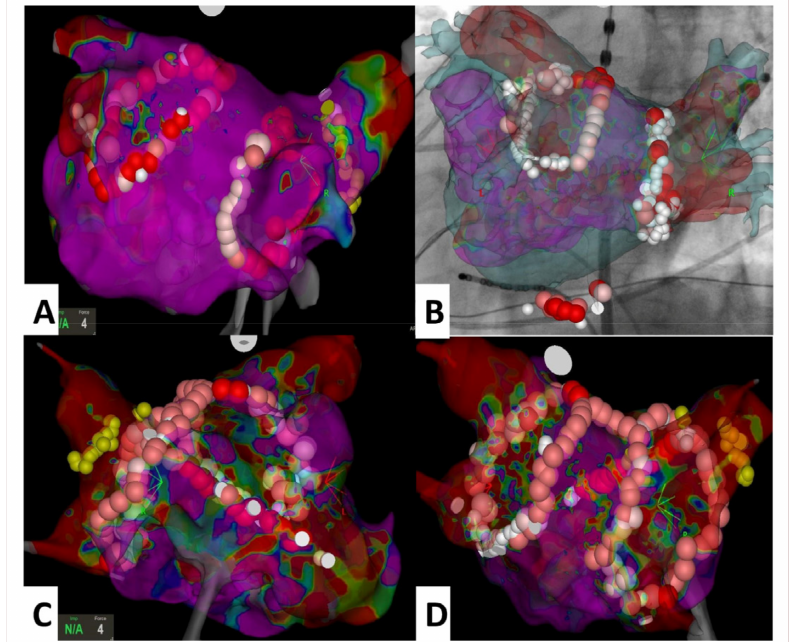
Figure 2. Views presenting the most common ablation lines performed for arrhythmogenic substrate modification. Panel ( A ) (PVI only), panel ( B ) (PVI and CTI line, Univu module), panel ( C ) and panel ( D ) (PVI, roof line and septal line). Abbreviation: CTI—cavotricuspid isthmus, PVI—pulmonary vein